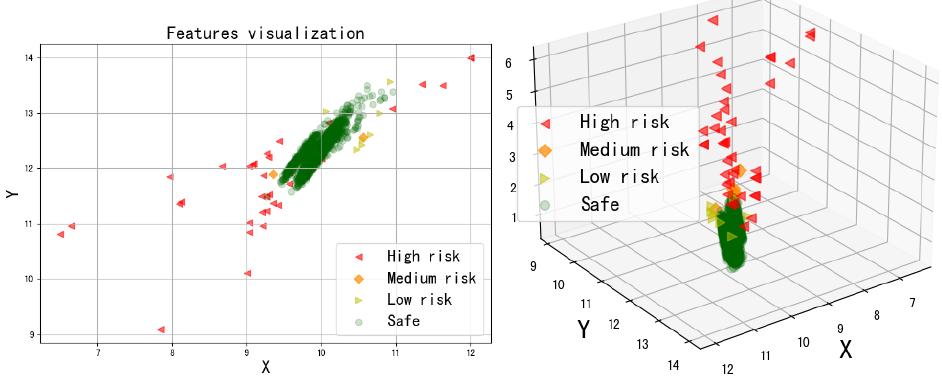
Figure 9. Visualization to represent four risk levels by 2D ( left ) and 3D ( right ). The ( X , Y ) and Z denote each sample’s 2D coordinates and risk